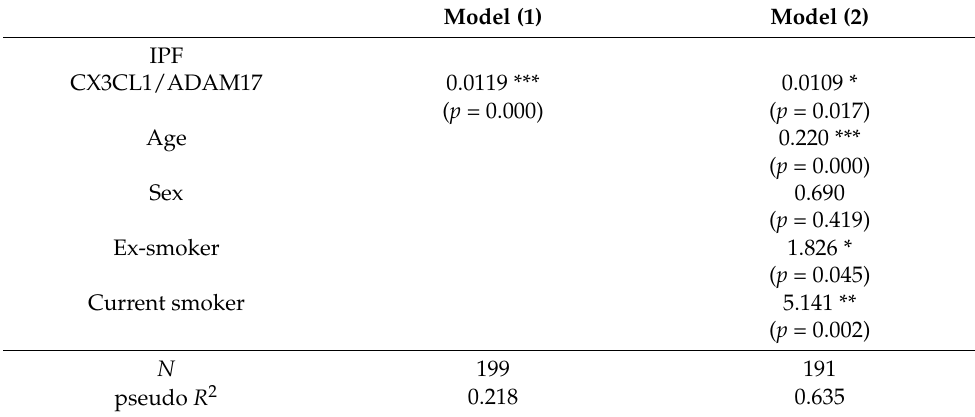
Table 5. Logit models of CX3CL1/ADAM17 effect on IPF.